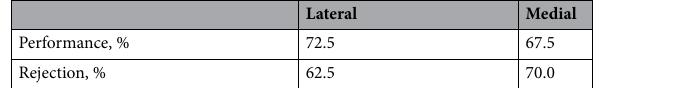
Table 3. Performance and rejection rates of KS-based discrimination for Lateral and Medial image